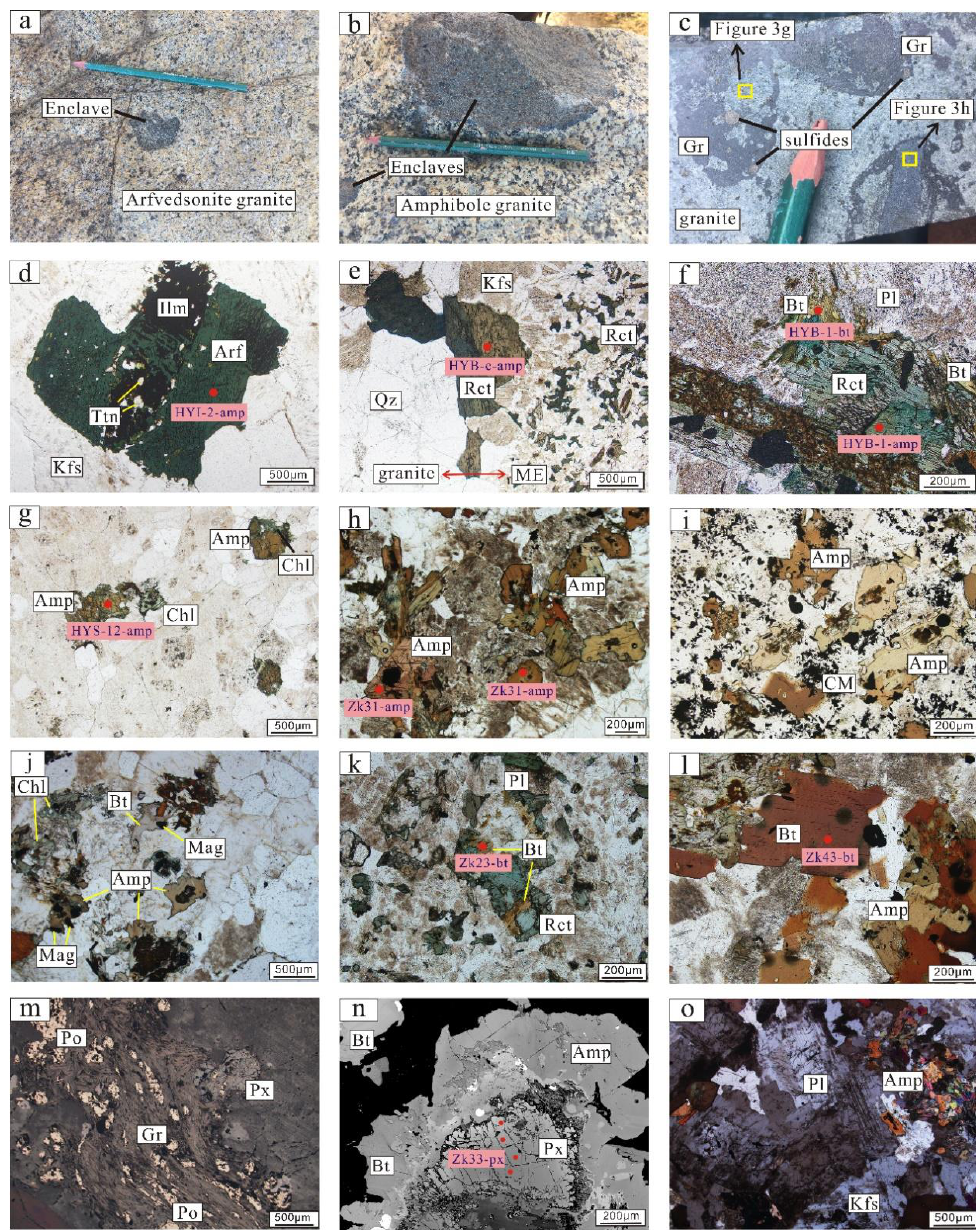
Figure 3. Photographs ( a – c ) and photomicrographs ( d – o ) of representative granite and graphite ore samples of the Huangyangshan pluton. The pink points represent some measuring locations. ( a ) A dark-colored ME in arfvedsonite granite. ( b ) Enclaves of different sizes in amphibole granite. ( c )